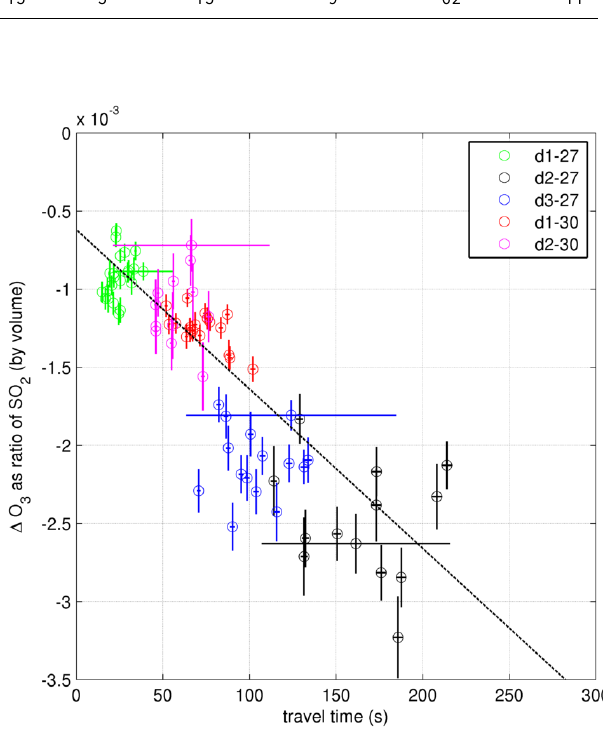
Figure 5. (cid:49) O 3 / SO 2 against calculated processing time at the in- plume measurement sites. The gradient of the linear line of best fit is − ( 1 . 02 ± 0 . 07 ) × 10 − 5 s − 1 and the y-intercept is ( − 6 . 2 ± 0 . 5 ) × 10 − 4 . Error bars are 1 standard deviation, accounting for both vari- ance in the values over the 120s of each bin and known errors of the